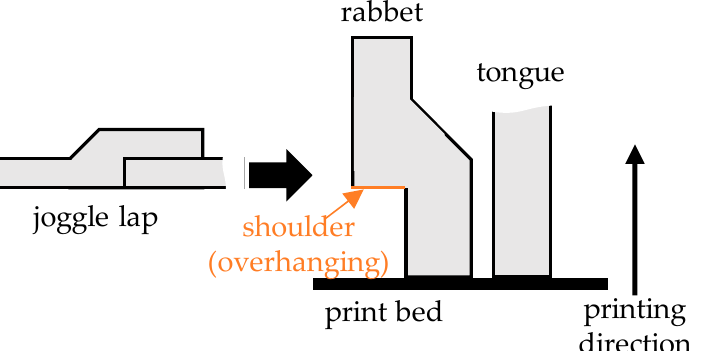
Figure 5. Joggle lap joint and the resulting orientation of the mating geometries for additive manu- facturing.